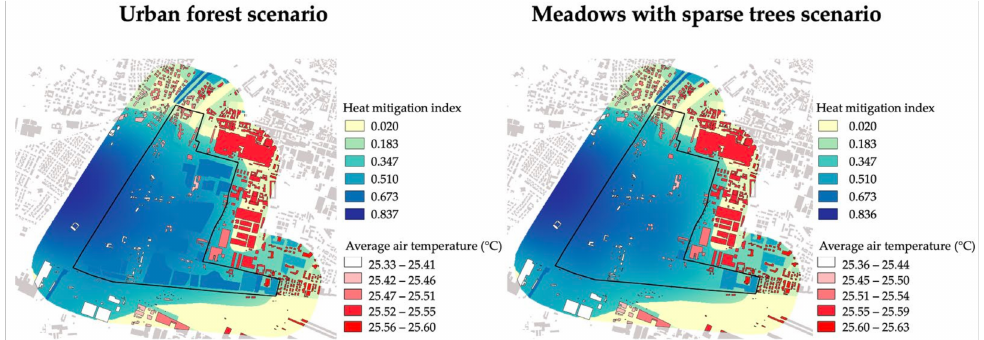
Figure 7. Heat mitigation index and average air temperature ( ◦ C) for the two intervention